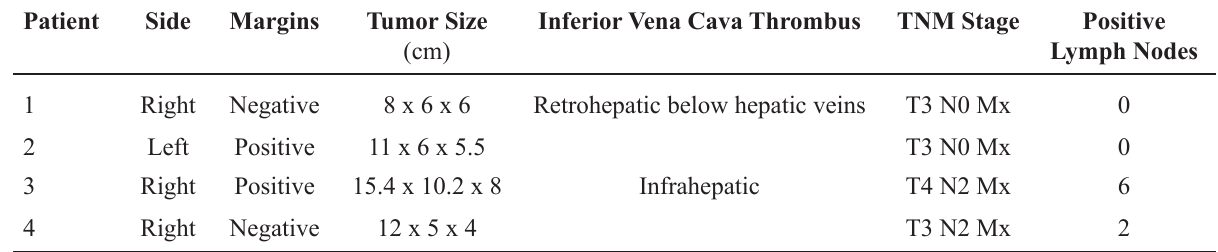
Table 2 – Tumor characteristics. High-grade urothelial carcinoma of the renal pelvis was the diagnosis in all cases.